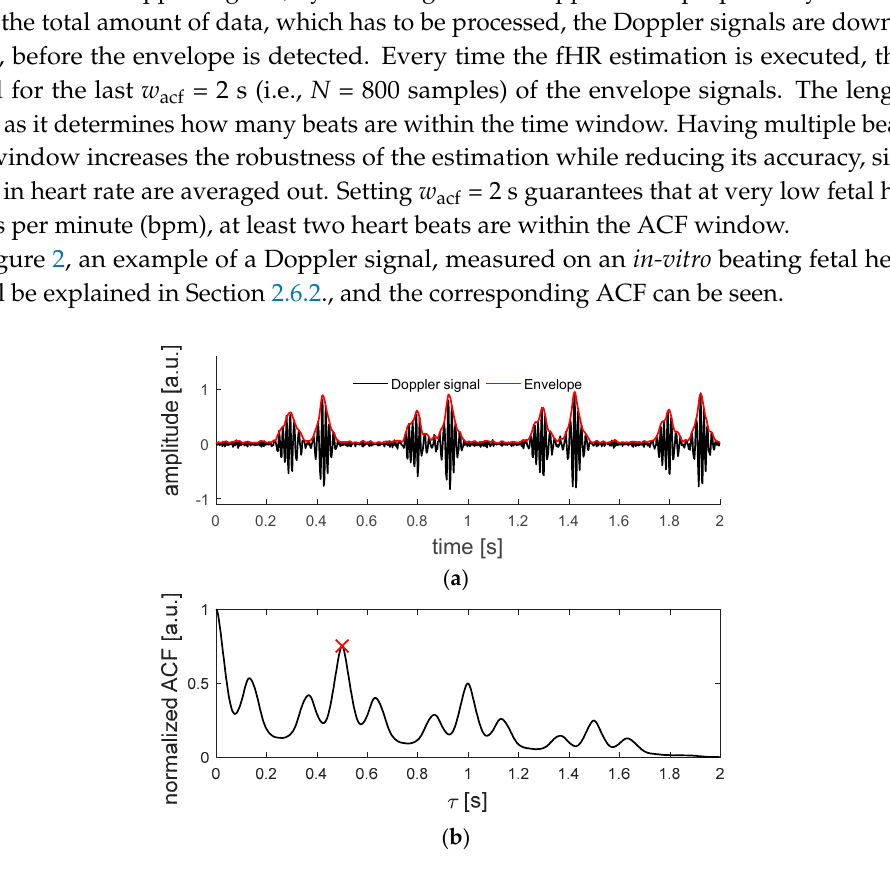
Figure 2. ( a ) Doppler signal acquired with a single element of the flexible transducer array, measured on an in-vitro beating fetal heart setup. In ( b ), the autocorrelation function is depicted. The maximum found at τ = 0.5 s corresponds to a heart rate of 120 bpm.